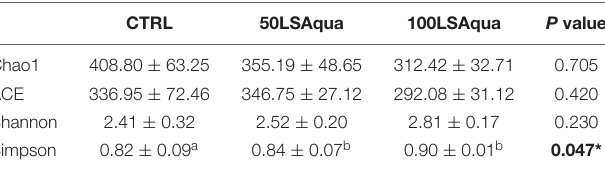
TABLE 3 | Species richness estimators (Chao1 and ACE) and diversity indexes (Shannon and Simpson) of 9 fish of CTRL, 50LSAqua and 100LSAqua groups.